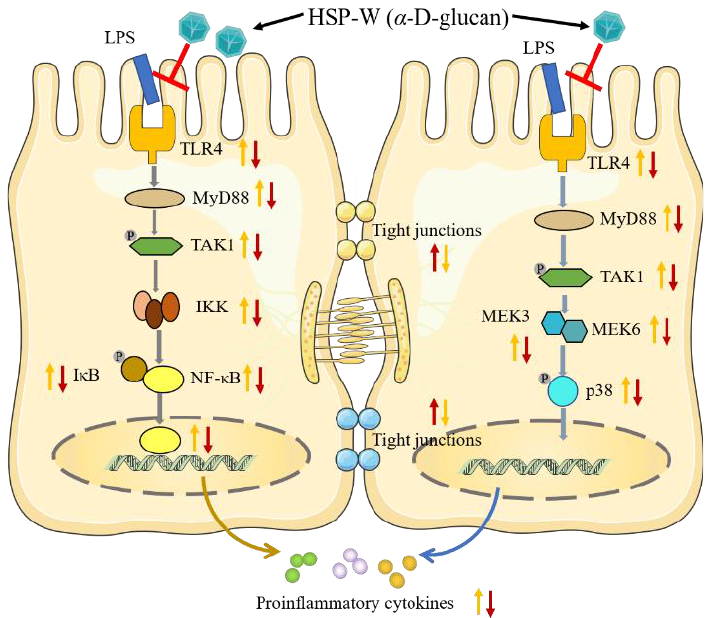
Figure 6. Schematic diagram summarizing the mechanisms underlying the protective effect of HSP-W against LPS-induced inflammation in Caco-2 cells.